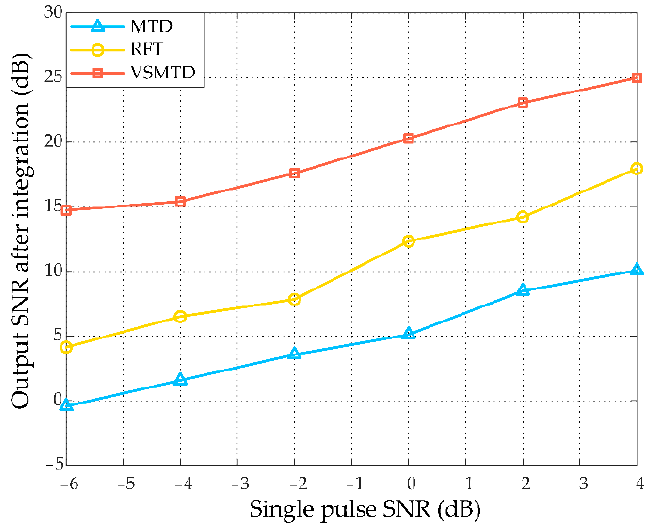
Figure 19. Integration gain comparison of different methods.